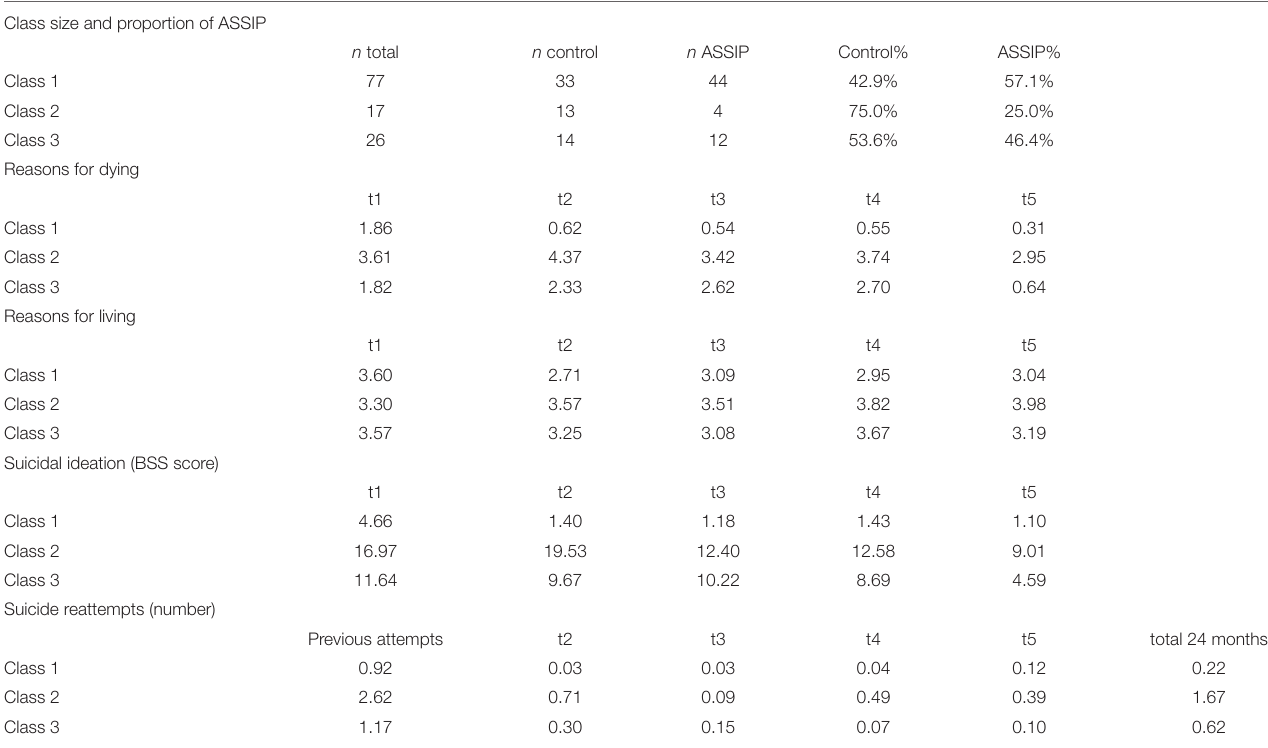
TABLE 3 | Properties and covariates for the latent class